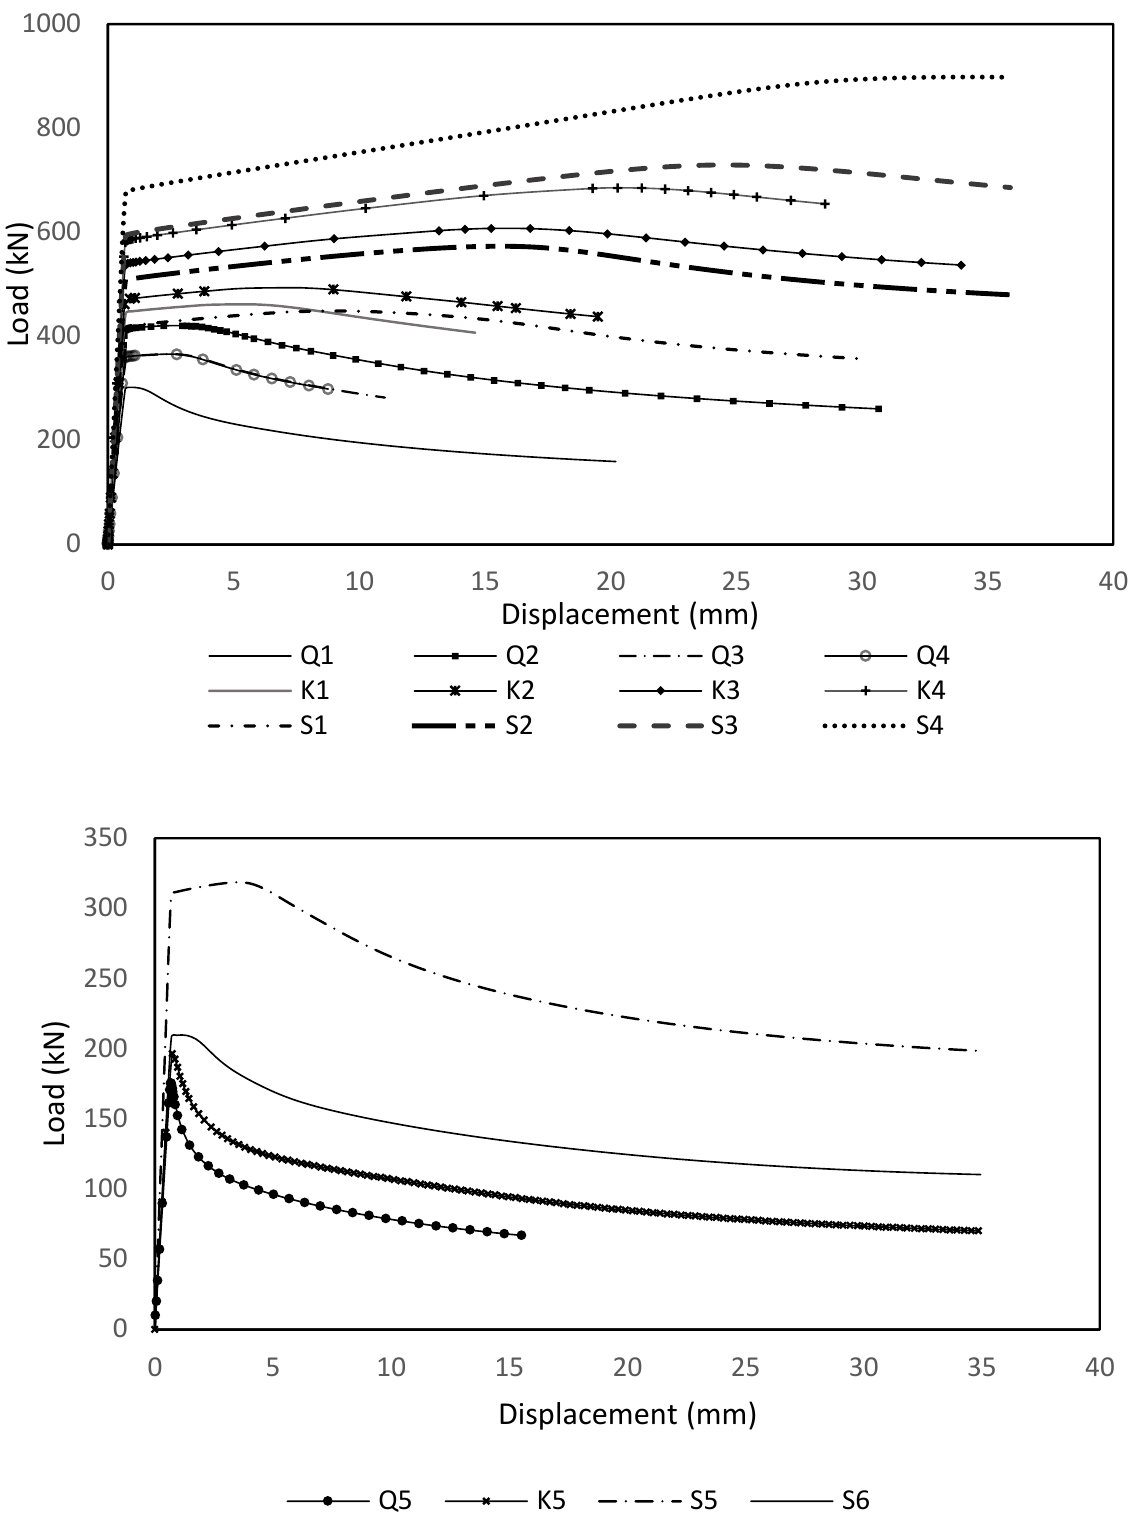
Figure 6. Load–displacement curves for each stocky column Figure 6. Load – displacement curves for each stocky column (FEA).